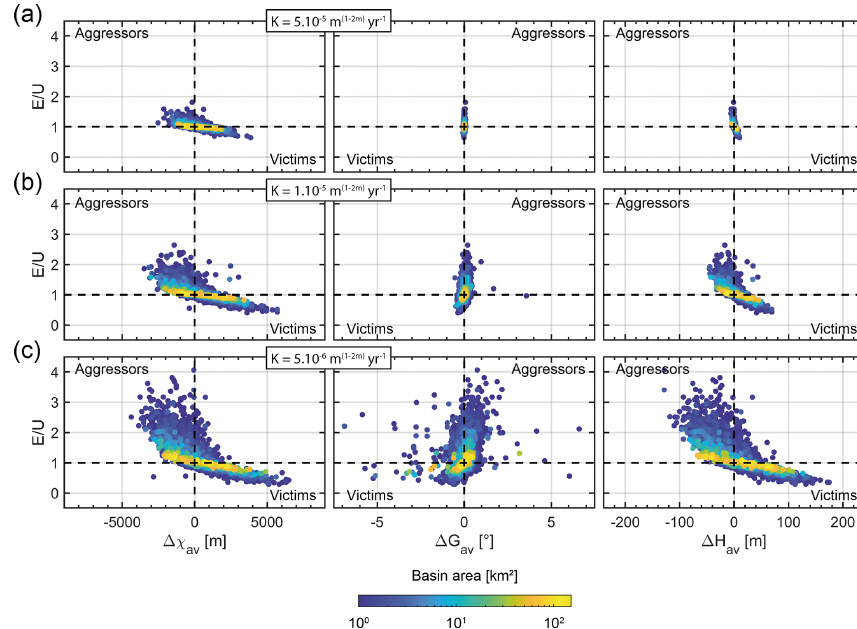
Figure 9. Effect of erodibility. Colour scale indicates basin area. Basins of variable sizes are sorted into seven area classes expanding geometrically with a multiplying factor of 2 from 1–2 to 64–128km 2 , every 0.5Myr over the time period 5–10Myr. Basins with a confidence index lower than 50% are discarded from the analysis. (a) Results with an erodibility coefficient of 5 × 10 − 5 m (1 − 2m) yr − 1 . (b) Results with an erodibility coefficient of 1 × 10 − 5 m (1 − 2m) yr − 1 . (c) Results with an with an erodibility coefficient of 5 × 10 − 6 m (1 − 2m) yr − 1